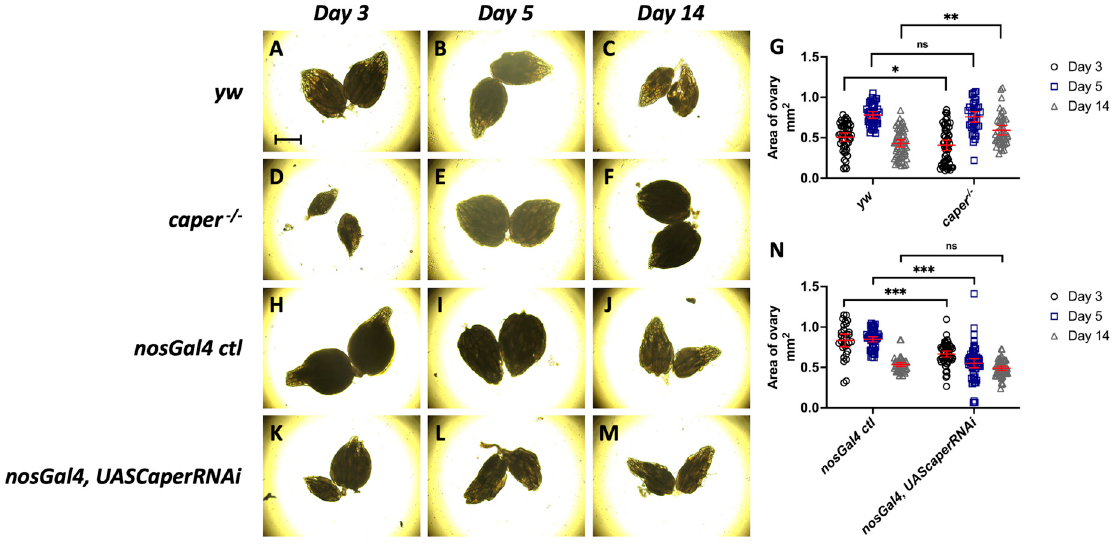
Figure 4. caper dysfunction results in smaller ovaries. ( A – F ) Images of ovaries dissected from yw and caper − / − females at days 3, 5 and 14 post-eclosion using a Brightfield microscope. ( G ) Quantification of ovary area shows that ovaries from caper − / − females are significantly smaller at day 3 ( caper − / − n = 50, average = 0.406 mm 2 , yw n = 46, average = 0.508 mm 2 , Tukey’s test: t -ratio = − 2.128, p = 0.0352) and significantly larger at day 14 ( caper − / − n = 44, average = 0.593 mm 2 , yw n = 68, average = 0.451 mm 2 , Tukey’s test: t -ratio = 3.147, p = 0.002) than ovaries from yw females. There is no significant difference in ovary size at day 5 ( caper − / − n = 36, average = 0.759 mm 2 , yw n = 40, average = 0.782 mm 2 , Tukey’s test: t -ratio = − 0.427, p = 0.6697). ( H – M ) Images of ovaries dissected from nosGal4 ctl and nosGal4 , UASCaperRNAi GLC01382 females at days 3, 5 and 14 post-eclosion using a Brightfield microscope. ( N ) Quantification of ovary area shows that ovaries from nosGal4 , UASCaperRNAi GLC01382 females are significantly smaller at day 3 ( nosGal4, UASCaperRNAi GLC01382 n = 54, average = 0.666 mm 2 , nosGal4 ctl n = 30, average = 0.835 mm 2 , Tukey’s test: t -ratio = − 4.188, p = 4.92e × 10 − 5 ) and day 5 ( nosGal4:UASCaperRNAi GLC01382 n = 56, average = 0.552 mm 2 , nosGal4 ctl n = 50, average = 0.848 mm 2 , Tukey’s test: t -ratio = − 8.619, p = 1.19 × 10 − 14 ) than ovaries from nosGal4 ctl . At day 14 there is not a significant difference in ovary size ( nosGal4:UASCaperRNAi GLC01382 n = 48, average = 0.536 mm 2 , nosGal4 ctl n = 58, average = 0.491 mm 2 , Tukey’s test: t -ratio = 1.298, p = 0.1964). Scale bar on panel A represents 500 µ m.Lines within each graph represent the mean and 95% confidence interval and significance is indicated by * p ≤ 0.05, **, p ≤ 0.01, *** p ≤ 0.001 or ns (not